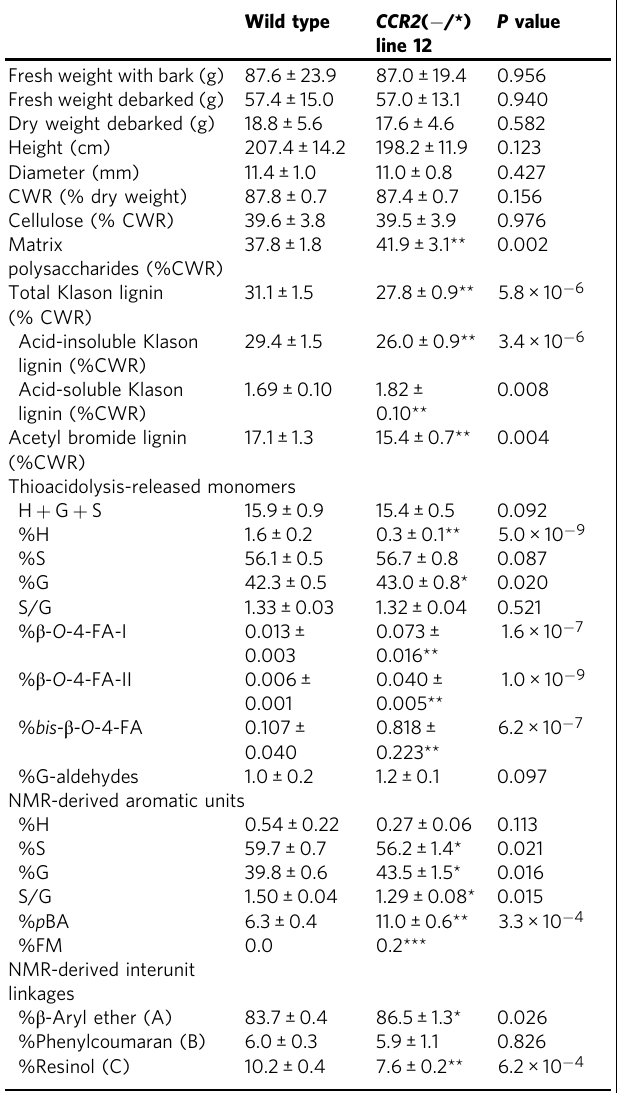
Table 1 Biomass and cell wall composition of CCR2 ( − /*) line 12